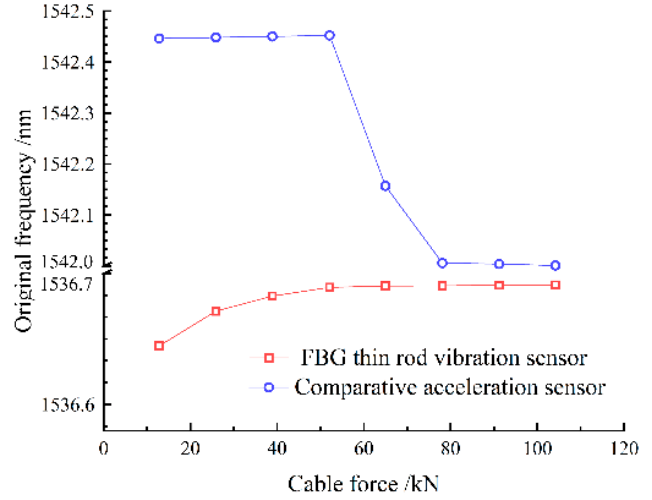
Figure 11. Slim rod induction meter graded loading initial wavelength of each stage.